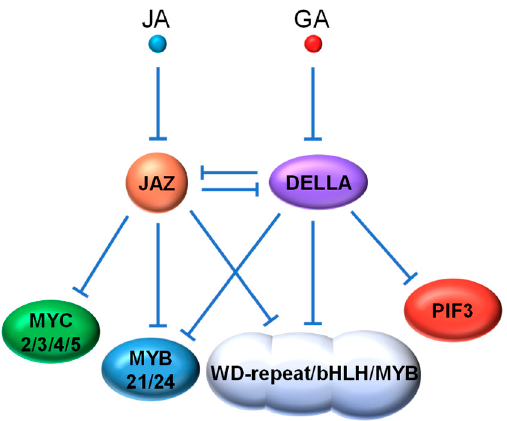
Figure 4. Simplified schematic of crosstalk between JA and GA signaling pathways. Both the antagonism and synergy between JA and GA signaling pathways are mainly mediated by the crosstalk between JAZ and DELLA proteins. Through binding competition, JAZ and DELLA reciprocally affect each other’s ability or availability to repress their respective target TFs (i.e., MYC2 for JA signaling; PIF3 for GA signaling). Both DELLAs and JAZs also interact with the bHLH and MYB components in the WD-repeat/bHLH/MYB and MYC-MYB complexes to repress their transcriptional activity. JA and GA, respectively, induce the degradation of JAZs and DELLAs, which additively activate JA- and GA-mediated processes, such as trichome formation and filament elongation. PIFs, phytochrome interacting factors.